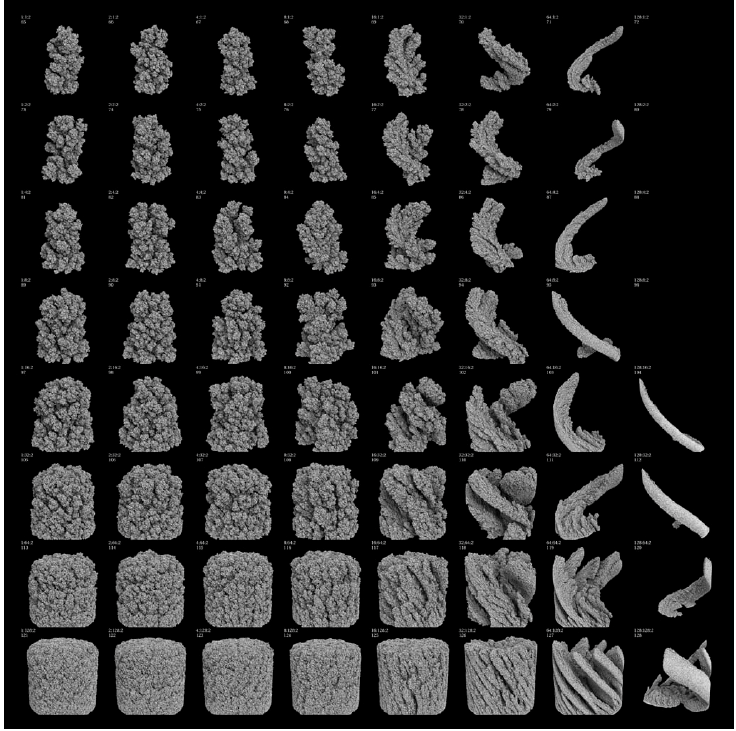
Figure 1. Phase space plot from the Aggregation series (Lomas 2005).